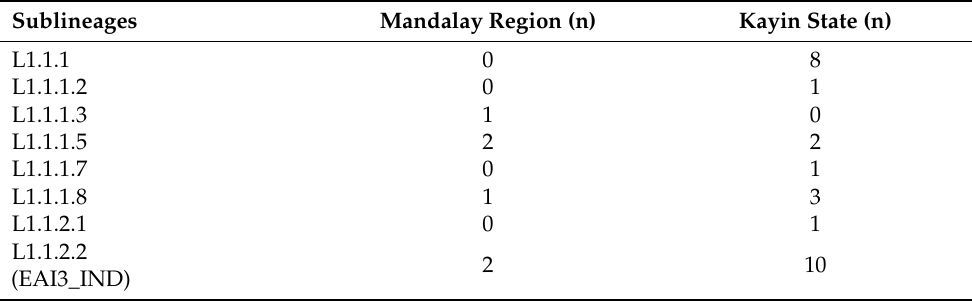
Table 2. Distribution of sublineages and biodiversity in Mandalay region and Kayin